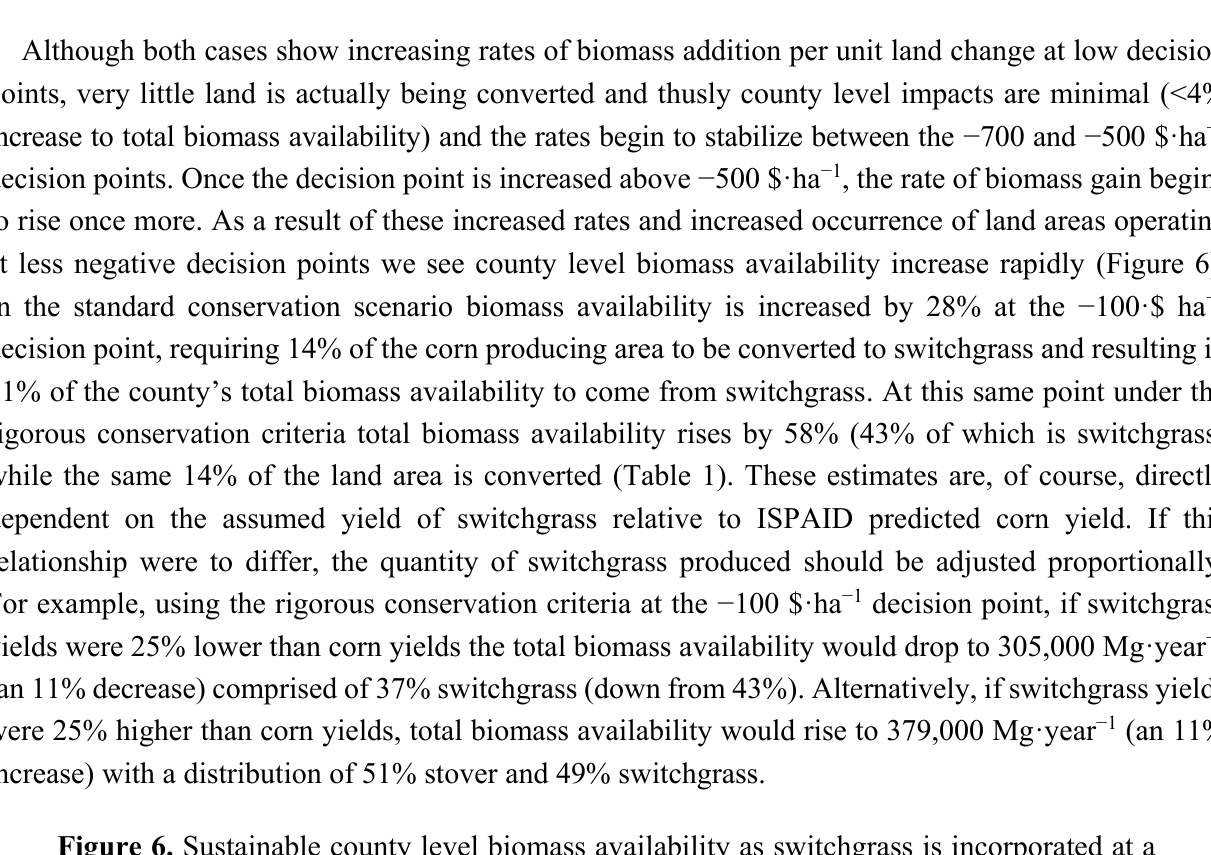
Figure 6. Sustainable county level biomass availability as switchgrass is incorporated at a range of net profit decision points for the standard conservation criteria (soil erosion < T and SCI > 0) and rigorous conservation criteria (soil erosion < ½ T and SCI and SCI-OM > 0) using a grain price of 0.20 $·kg −1